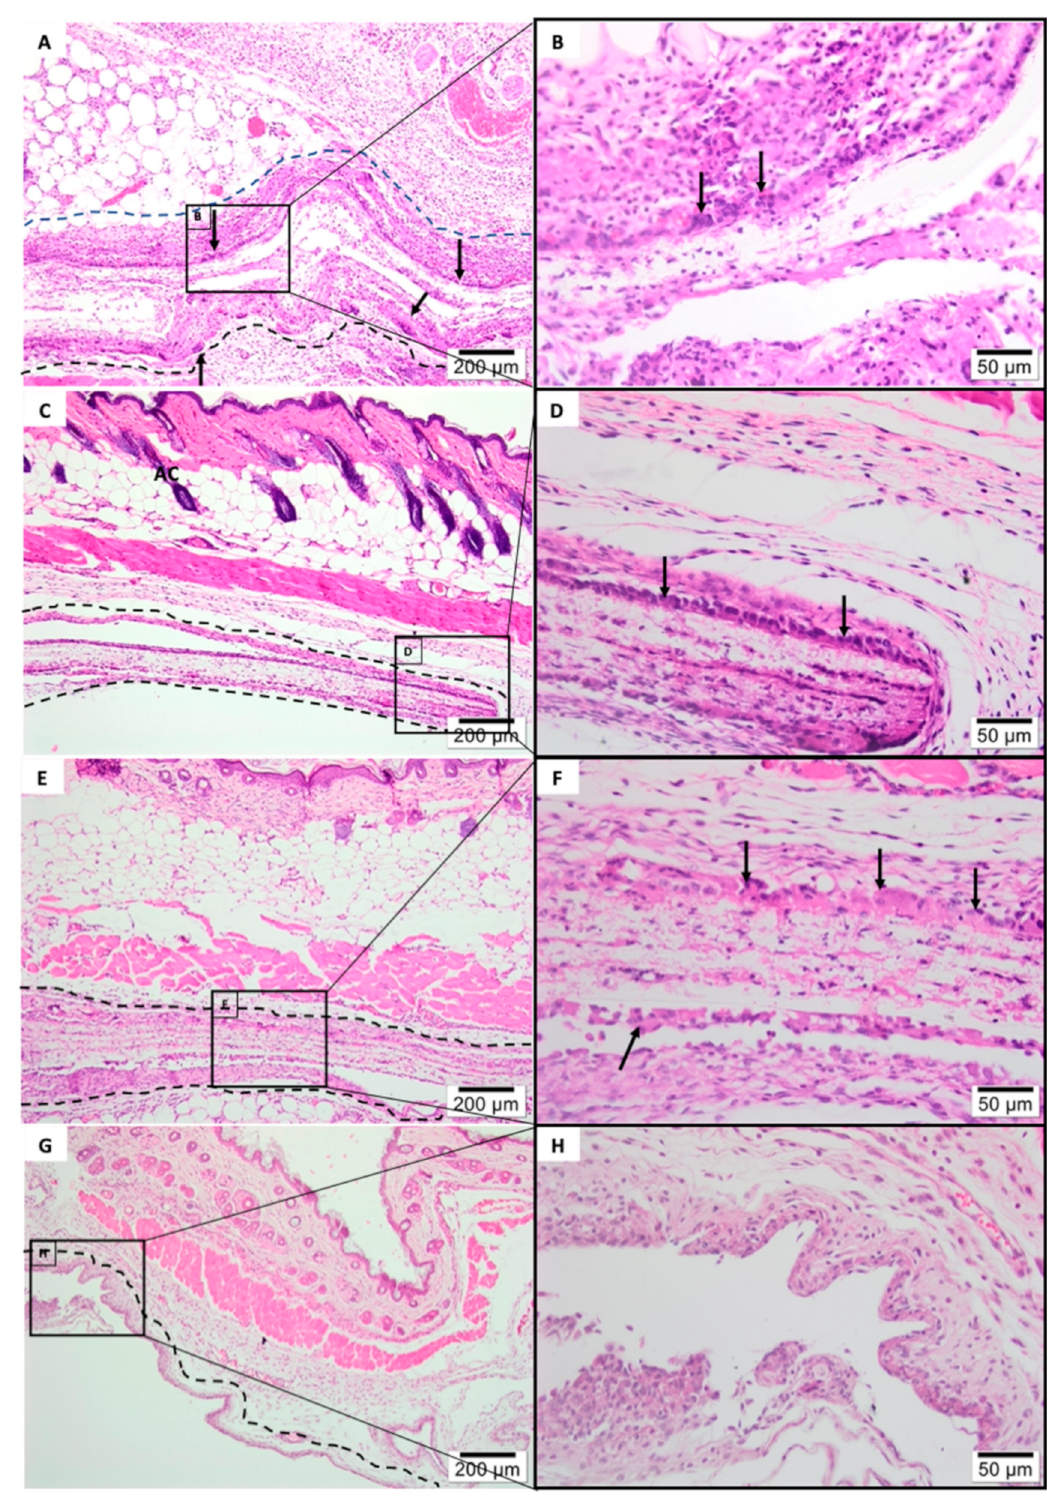
Figure 7. Histology of subcutaneous evaluation of 1-Week Post-implantation. Photomicrographs (optical mi- croscopy) stained with hematoxylin/eosin of the membrane implantation area (dotted line) at × 40/ × 400 magnifica- tion. ( A , B ) Tea tree Experimental Group, ( C , D ) Furanone Experimental Group, ( E , F ) Pure PLGA Experimental Group, ( G , H ) Pratix Experimental